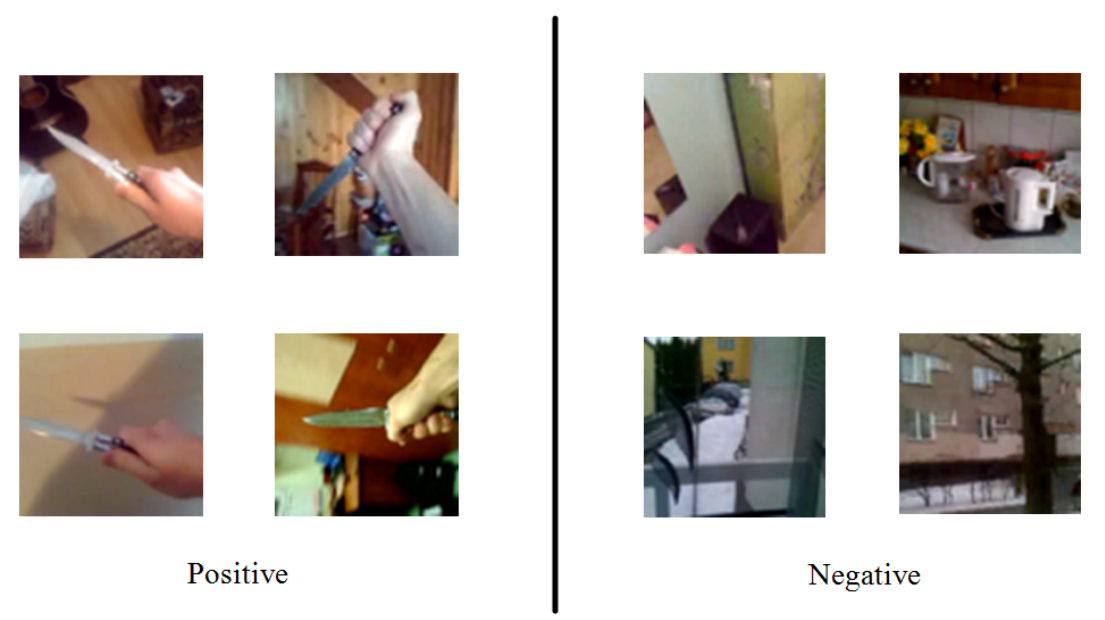
Figure 6. Sample images from the knife detection dataset: positive and